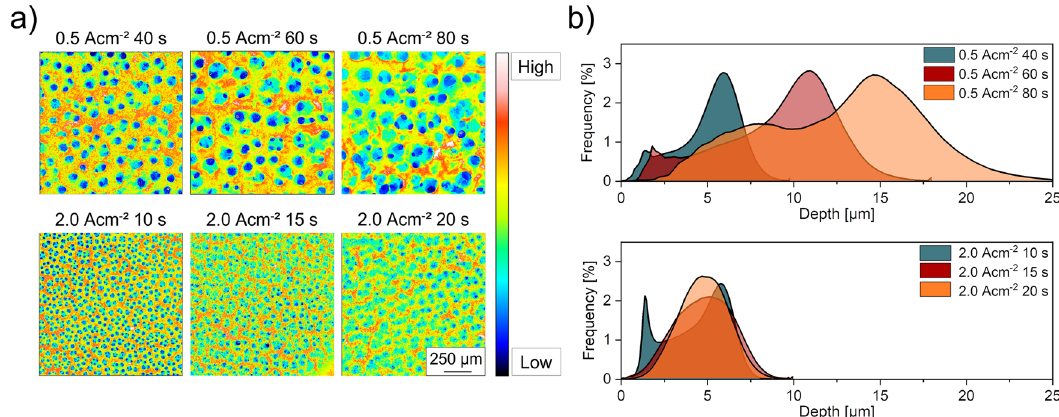
Fig. 6 Laser confocal scanning microscopy (LCSM) images of all tested samples and resulting pore-depth distribution. a Coloured 2D LCSM images of low current density and high current density foam electrodes with high (red to white) and low (blue to black) pore depths, b distribution of the pore depths in relation to the applied charge densities of all tested samples.